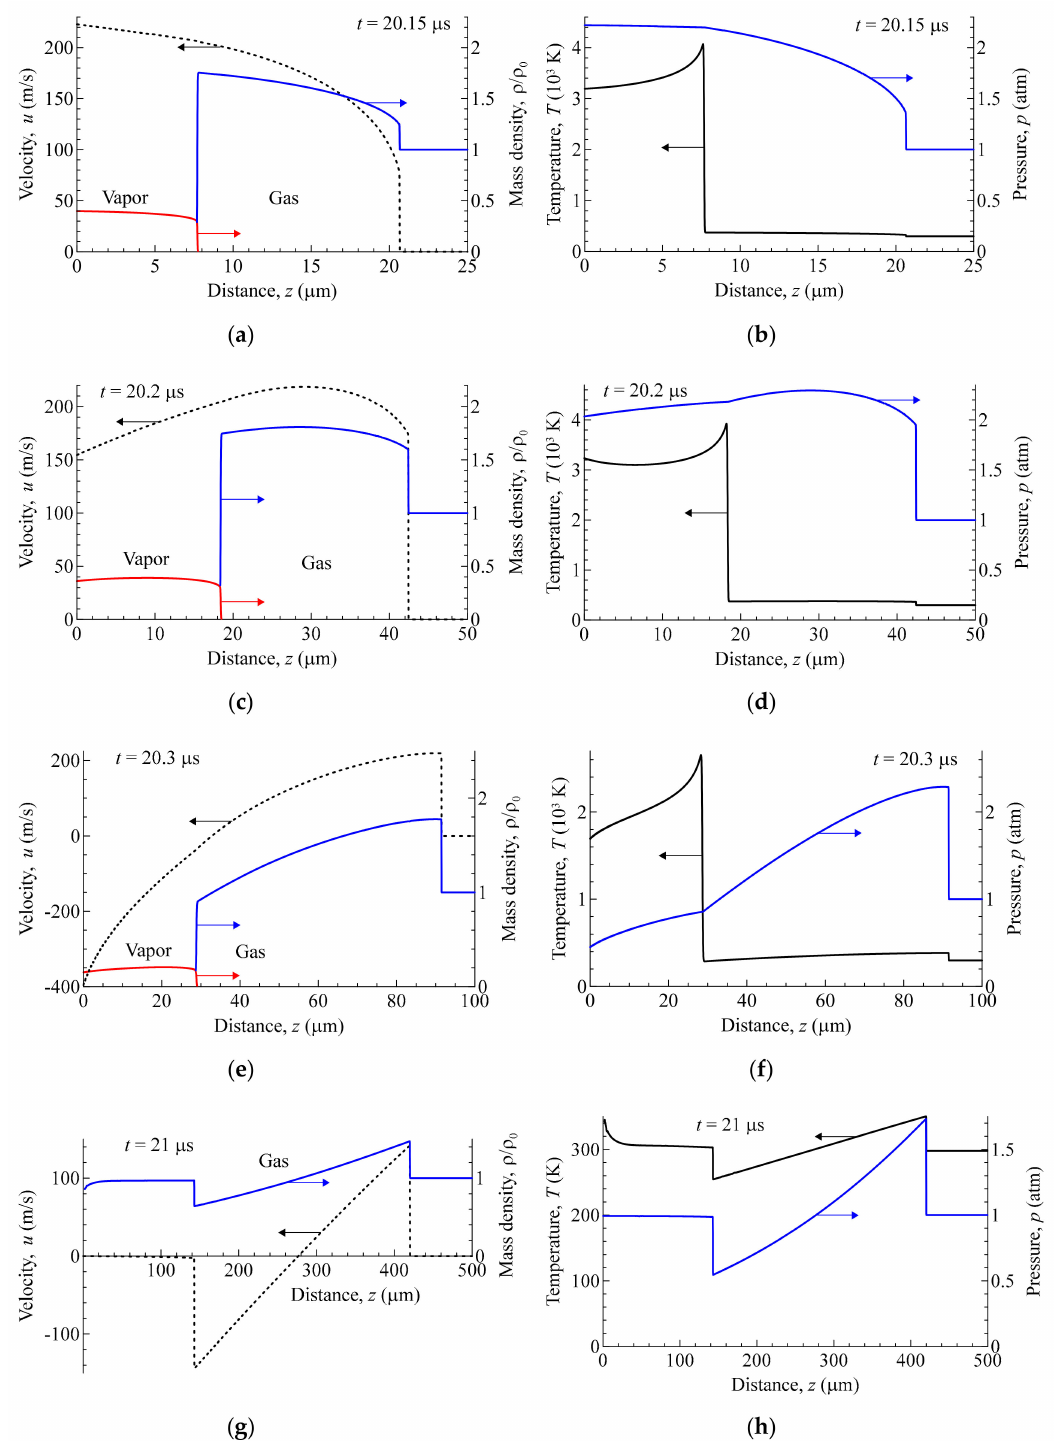
Figure 7. Evolution of the gas-dynamic fields after the third pulse of the sequence with I max = 10 MW / cm 2 and inter-pulse separation 10 µ s. The arrow near each curve points to the corresponding axis. The axis title contains the name of the physical quantity. Flow velocity (dashed curves) and mass densities of vapor (red curves) and gas (blue curves): ( a , c , e , g ). Temperature (black curves) and pressure (blue curves): ( b , d ), ( f , h ). Time t : 20.15 µ s ( a , b ); 20.2 µ s ( c , d ); 20.3 µ s ( e , f ); 21 µ s ( g , h